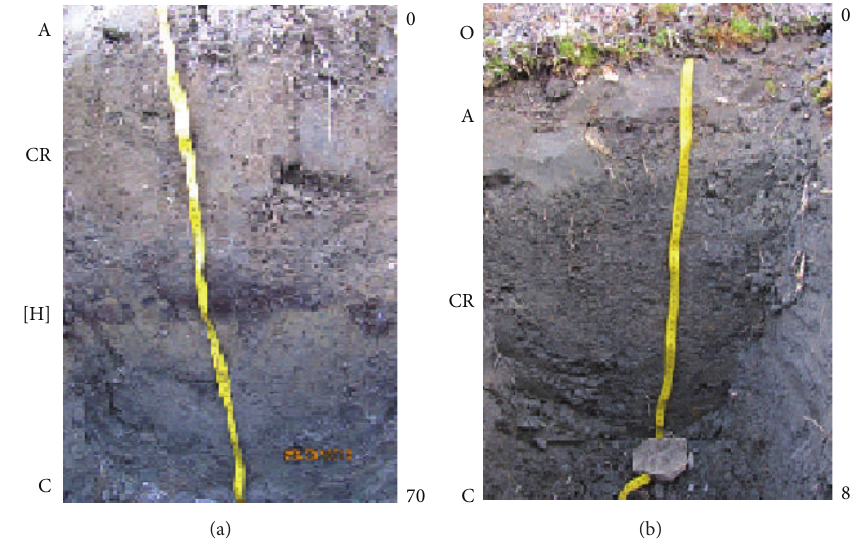
Figure 2: Soil profiles of the B. Lyakhovsky (a) and Wrangel (b) Islands.